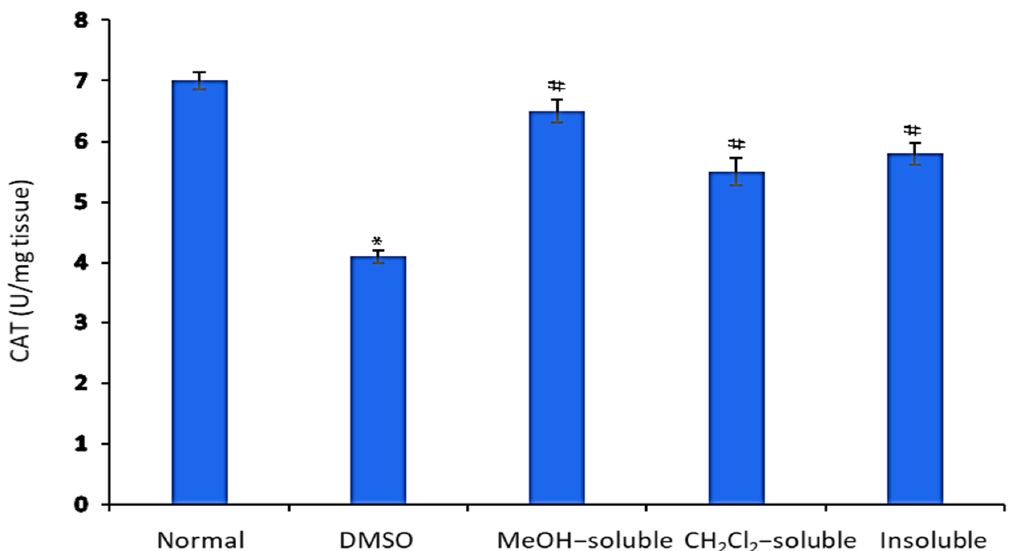
Figure 7. Effect of A. zerumbet extracts (MeOH, CH 2 Cl 2 , and insoluble) on catalase (CAT) activity. CAT levels were assessed in liver homogenate, data was represented as mean ± SEM and expressed as U/mg tissue. Significantly (* p < 0.001) different from the normal control (untreated) and significantly ( # p < 0.001) different from the vehicle control (tumor + DMSO).